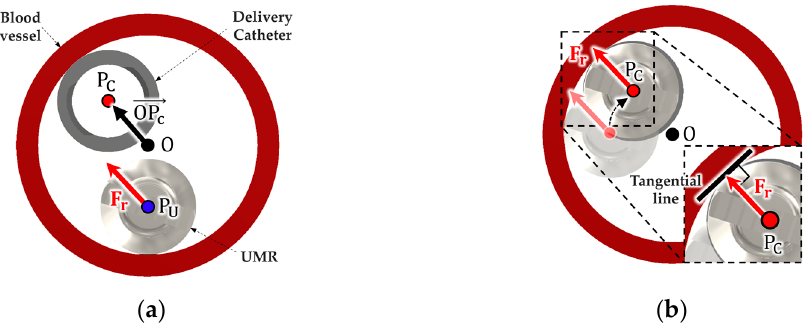
Figure 6. ( a ) F r in the direction from the center of the blood vessel to the center of the delivery catheter in the cross-section of the blood vessel; ( b ) a UMR moving to the point where the direction of F r makes a right angle with respect to the tangential vector of the inner wall of the blood vessel.